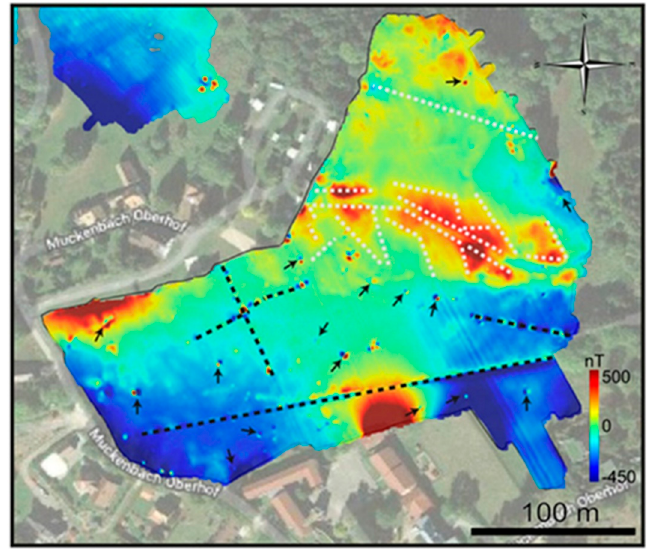
Figure 13. The magnetic map obtained by the fluxgate magnetometer on a UAV at the height of 100 m with a satellite image as the background.